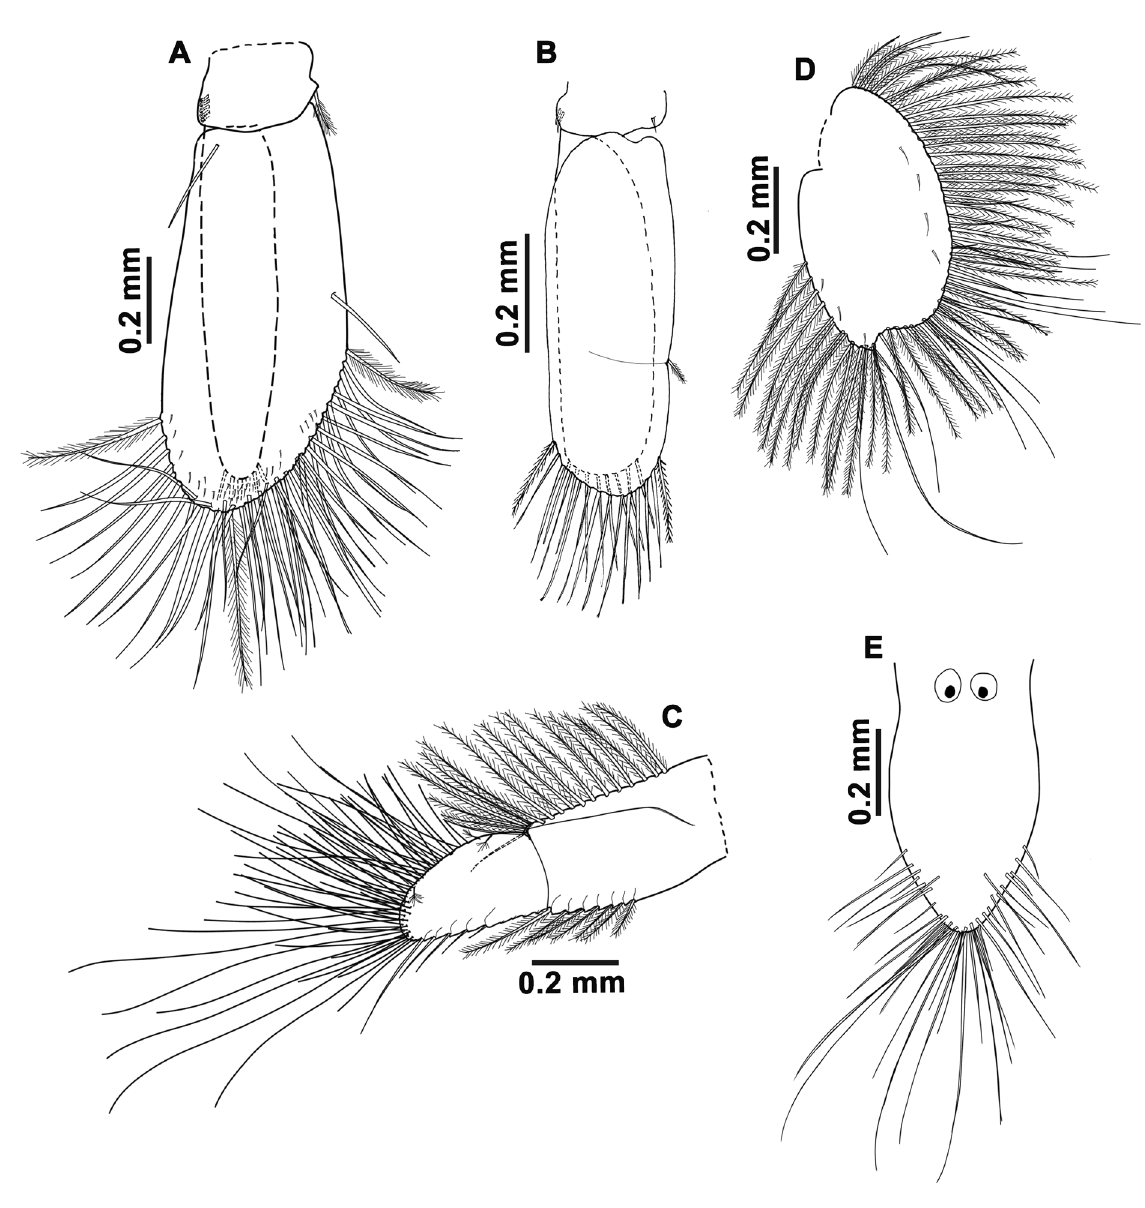
Fig. 4. Amakusanthura guerrerensis sp. nov., holotype, ♀, 5 mm, Guerrero, Ixtapa Island, Coral Beach (UMAR-PERA 522). A . Pleopod 1. B . Pleopod 2. C . Uropodal endopod. D . Uropodal exopod. E .